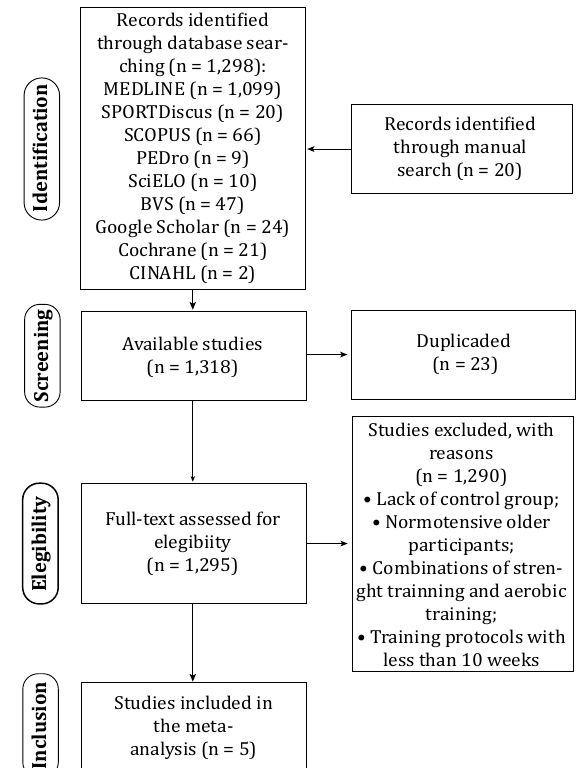
Figure 1 – Flow diagram of the studies